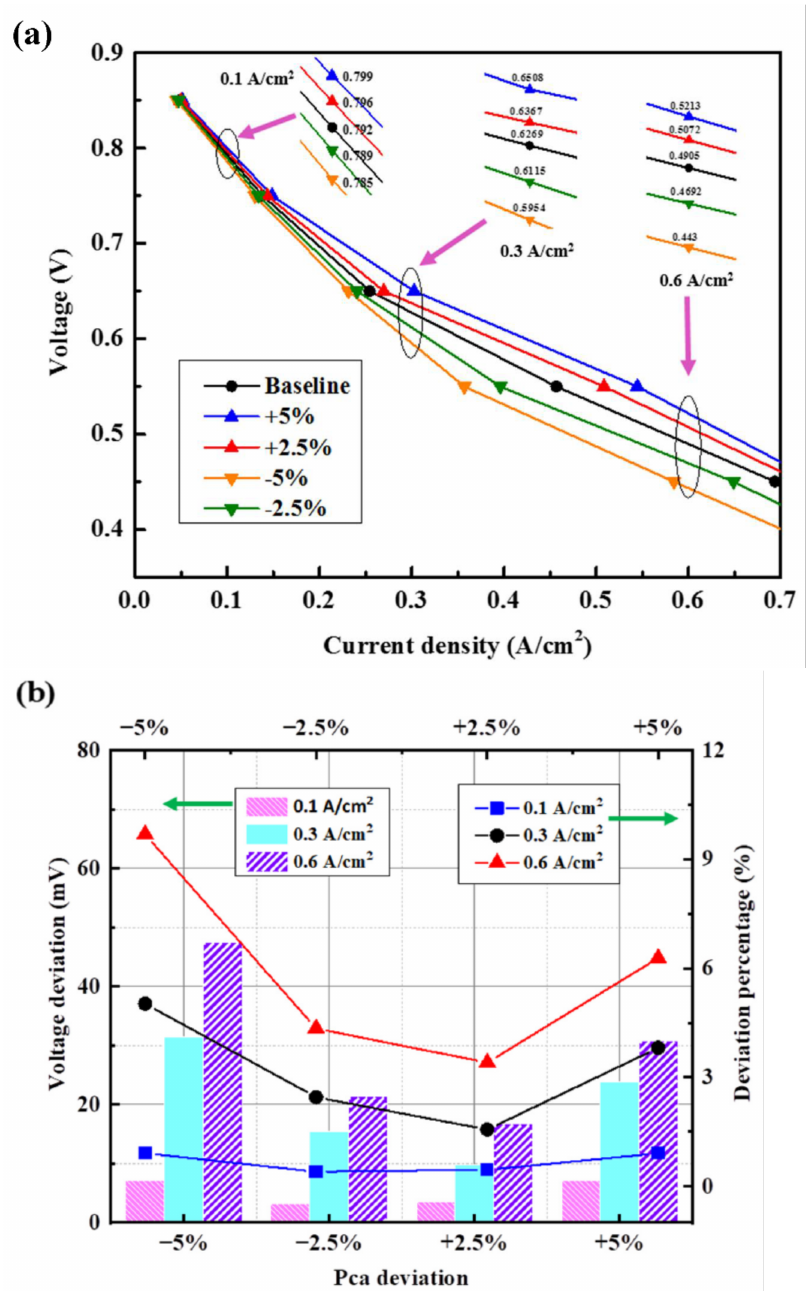
Figure 4. Impact of COP deviation on voltage: ( a ) polarization curves of different cathode operating pressure, ( b ) the voltage deviation obtained by COP deviations and their corresponding percentages under three current